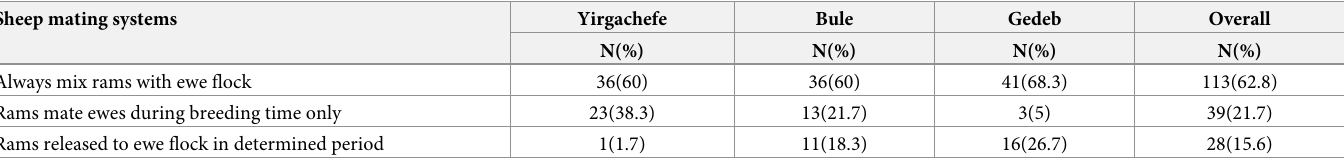
Table 3. Farmers’ systems of sheep mating. Sheep mating